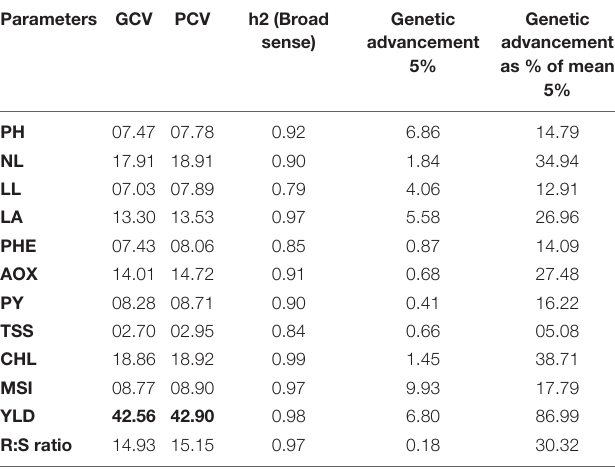
TABLE 11 | Estimate of genetic parameters for 12 quantitative traits of 12 contrasting onion genotypes. Parameters GCV PCV h2 (Broad sense)